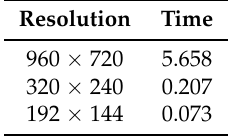
Table 1. The execution time for frame within a frame, in terms of seconds.